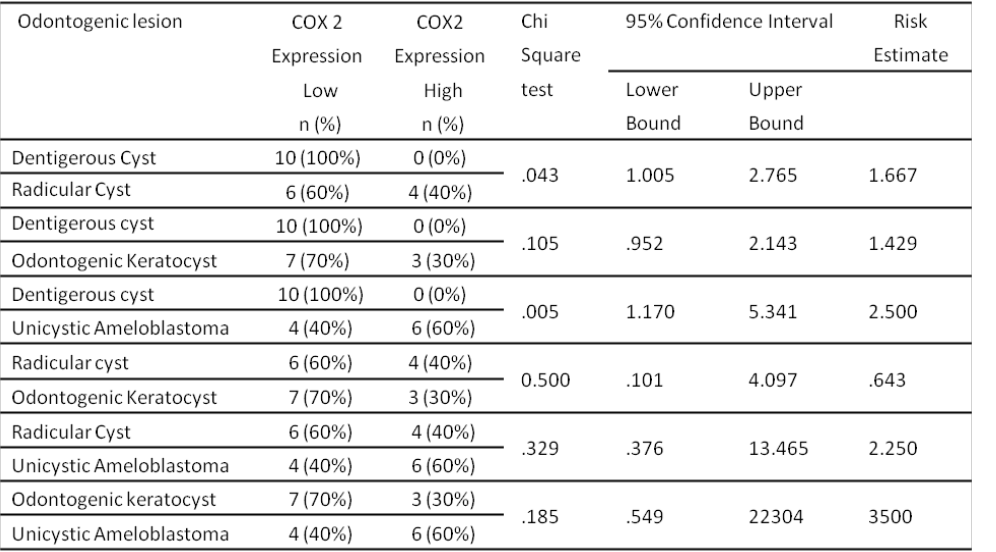
Table 5. Association of the expression of COX-2 (Total Score) and risk ratio among the odontogenic